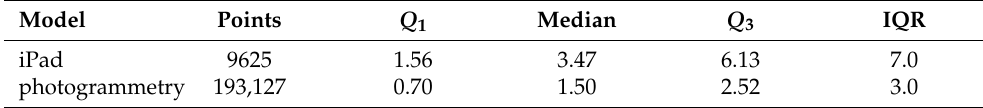
Table 3. Comparison of statistical values for the small architecture object [mm].